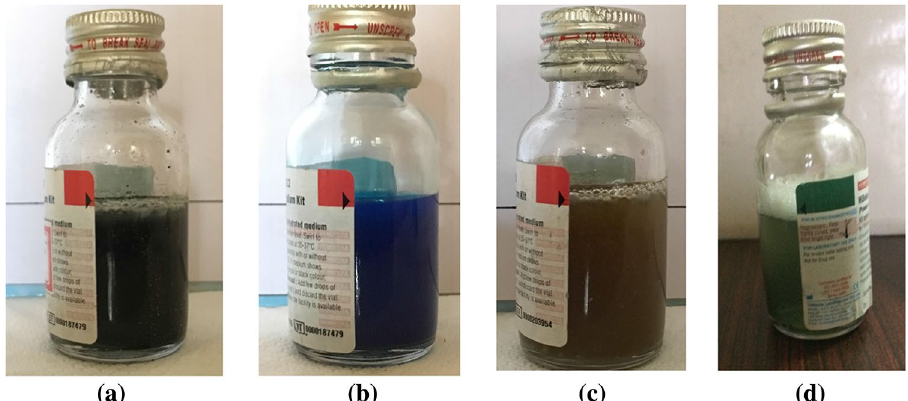
Fig. 12 Microbial analysis before treatment ( a – c ) and after treatment ( d ) with